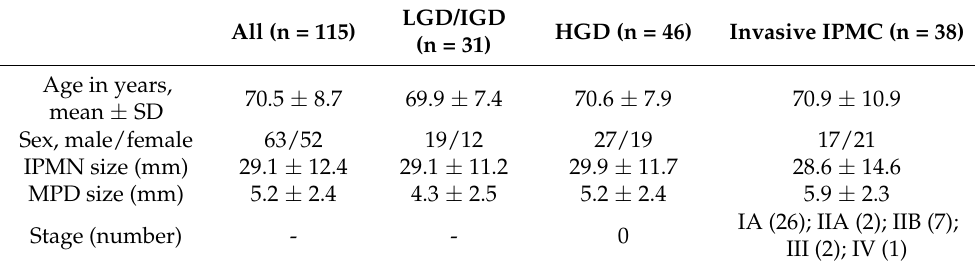
Table 1. Characteristics of the Patients with IPMN.